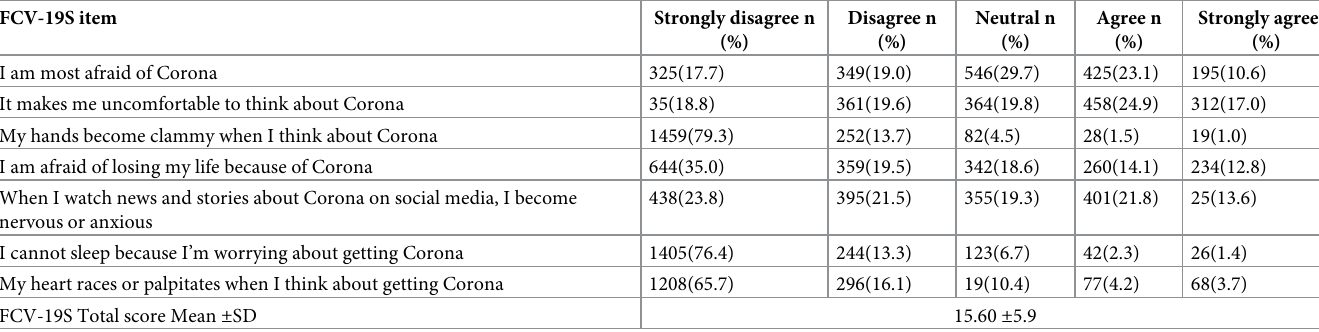
Table 2. Fear of COVID-19 among the study